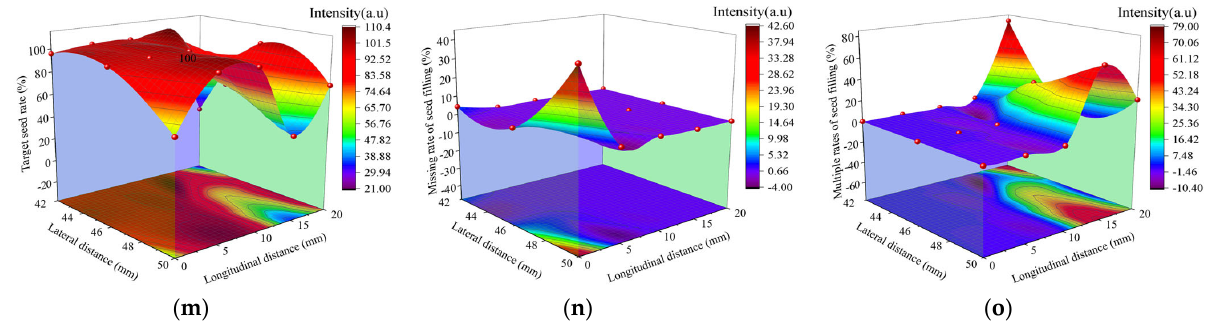
Figure 11. Target seed rate, missing rate of seed filling, and multiple rates of seed filling at different frequencies. ( a , d , g , j , m ) and m are the target seed rate; ( b , e , h , k , n ) are the missing rate of seed filling; ( c , f , i , l , o ) are the multiple rates of seed filling.